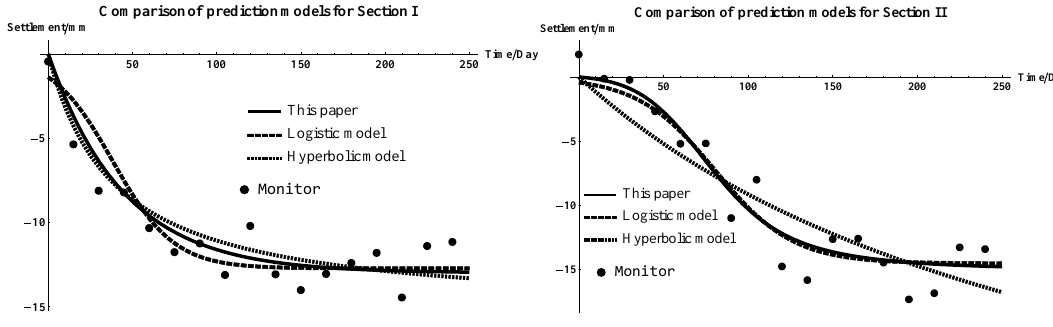
Figure 10. Verification for different sections of HTL.